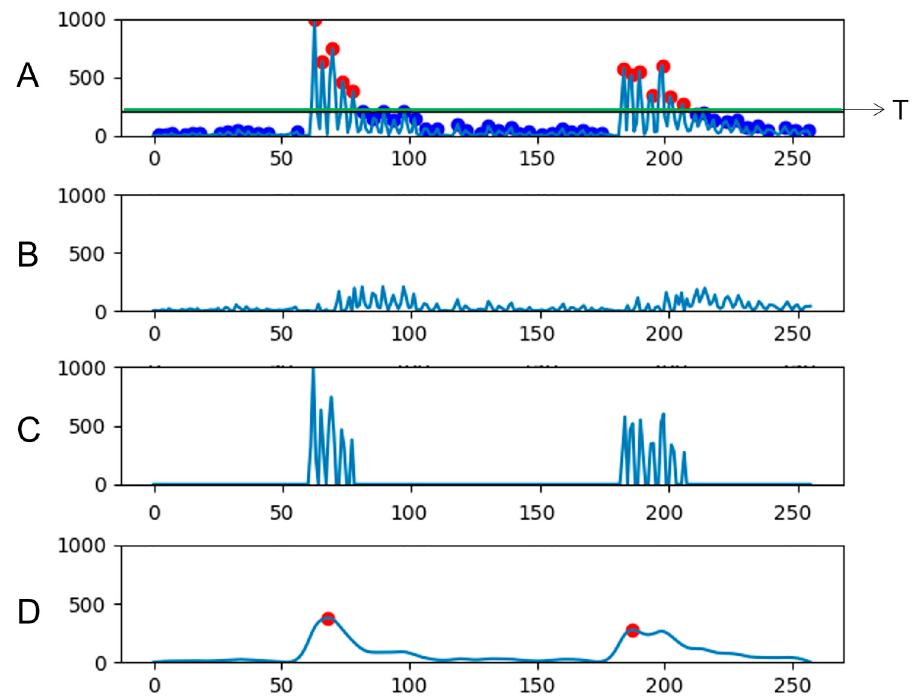
Figure 2. Graphical plot of a profile: y and x axis represent, respectively, CH 4 measured values (ppm-m) and length of measurement (s). ( A ) the signal plot with all identified CH 4 peaks: red dots and blue dots correspond, respectively, to eructation and respiratory CH 4 peaks, T indicates the threshold; ( B ) plot of CH 4 respiratory peaks; ( C ) plot of CH 4 eructation peaks; ( D ) plot of eructation events.